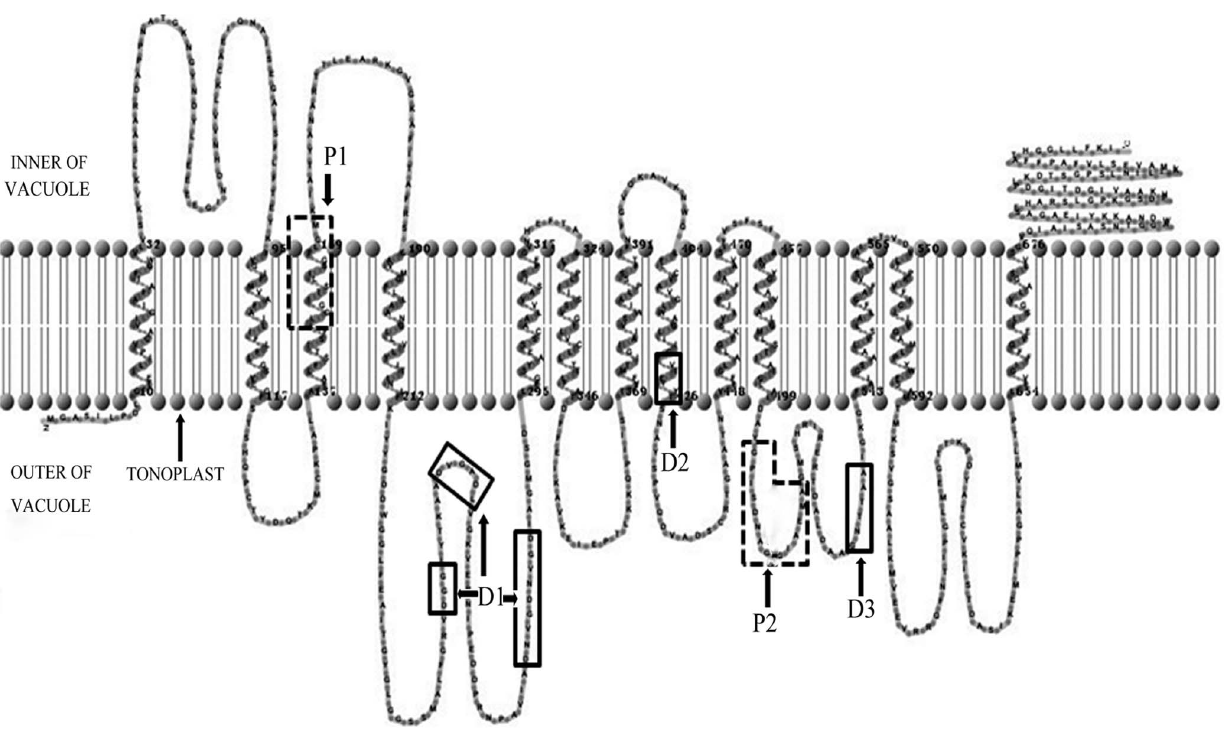
Figure 3. Tentative transmembrane model of H + -PPase from Sophoraalopecuroid generated by TMHMM online. There are 13 putative transmembrane regions. D1, D2 and D3 with solid rectangles are previously identified domains [26], and P1 and P2 with dotted rectangles are putative motifs that we predicted.